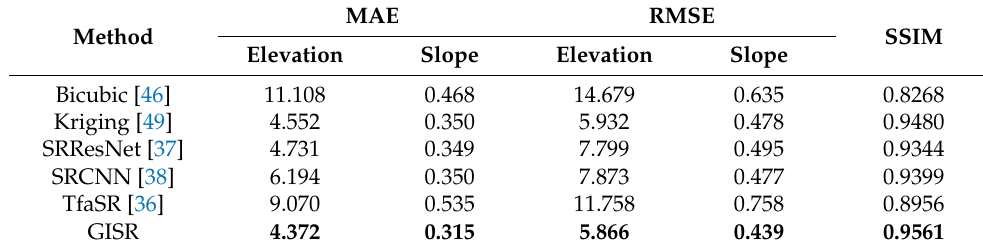
Table 5. Comparisons among different methods on the TfaSR dataset.